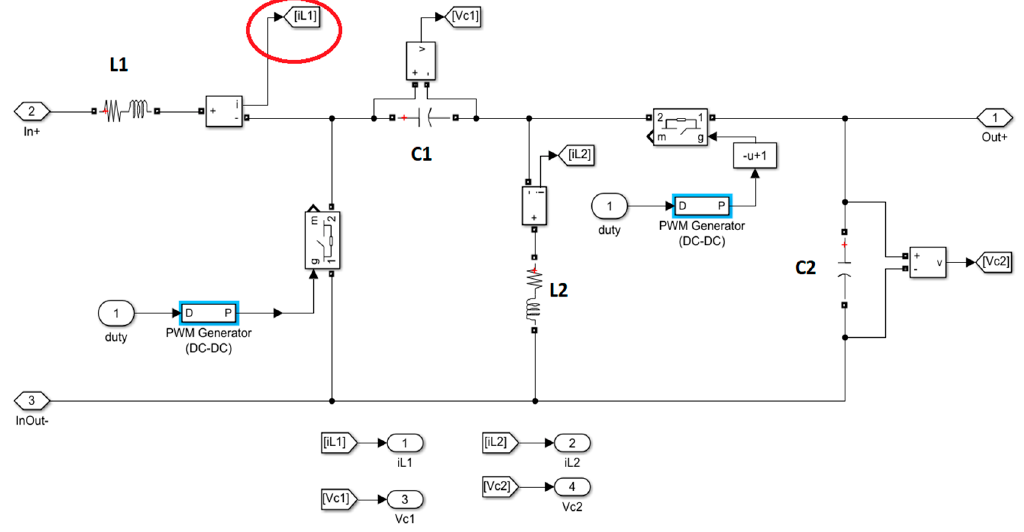
Figure 7. Structure of the SEPIC.